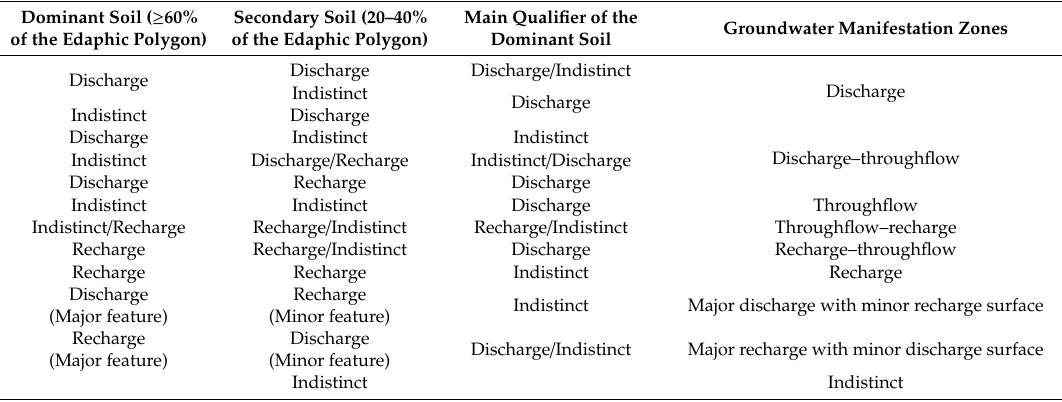
Table 1. Classifications of soil